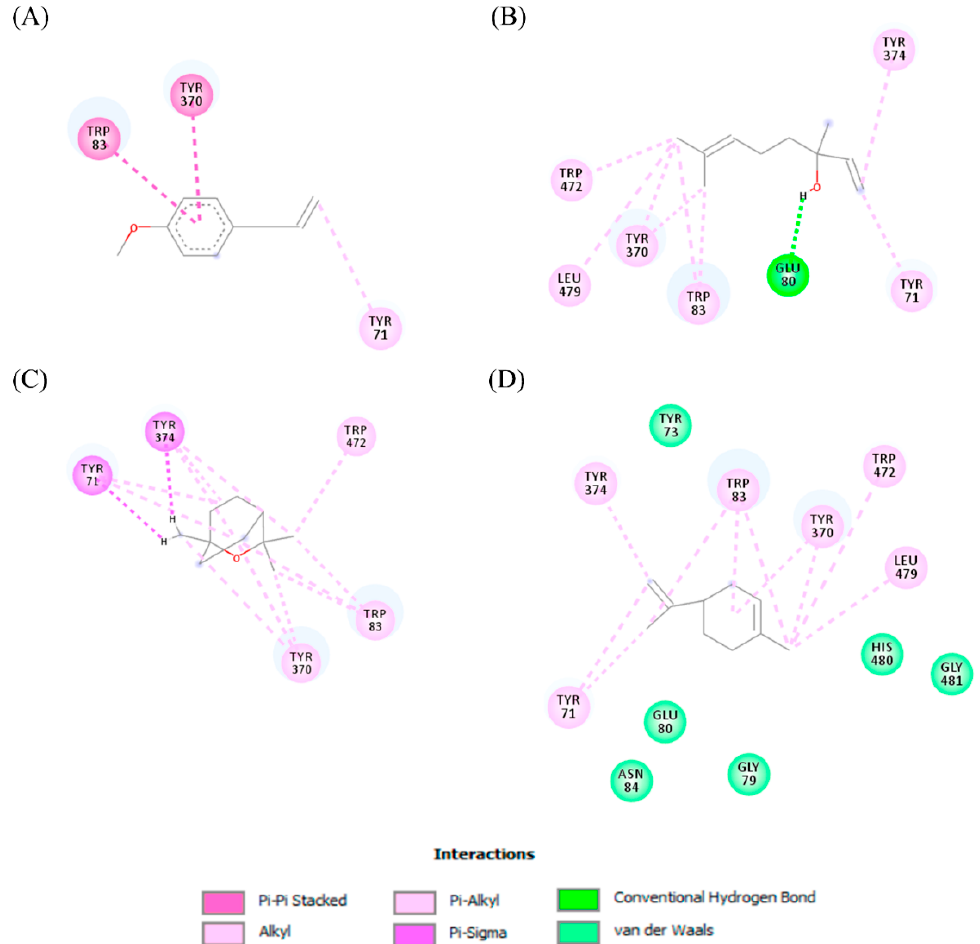
Figure 3. Molecular interactions established between ( A ) methyl chavicol, ( B ) linalool, ( C ) 1,8-cineole and ( D ) limonene with AChE pocket binding.